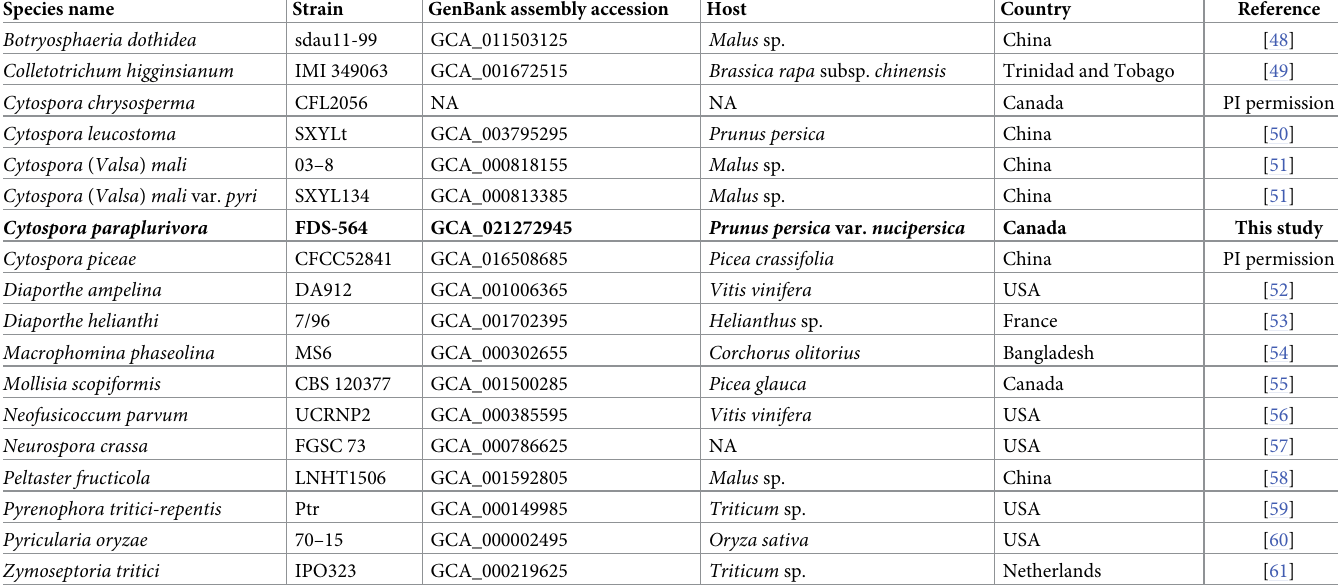
Table 2. Genomes used in phylogenomic analyses. Strains from this study are in bold. NA: not available. Species